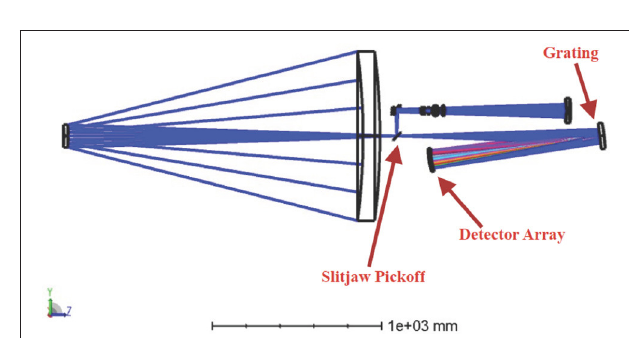
FIGURE 7 | MUVI telescope, spectrograph, and imager design. This design offers high throughput while maintaining low-resolution spectroscopy and ∼ arcsecond-level imaging for SN localization, galactic characterization, and light curve